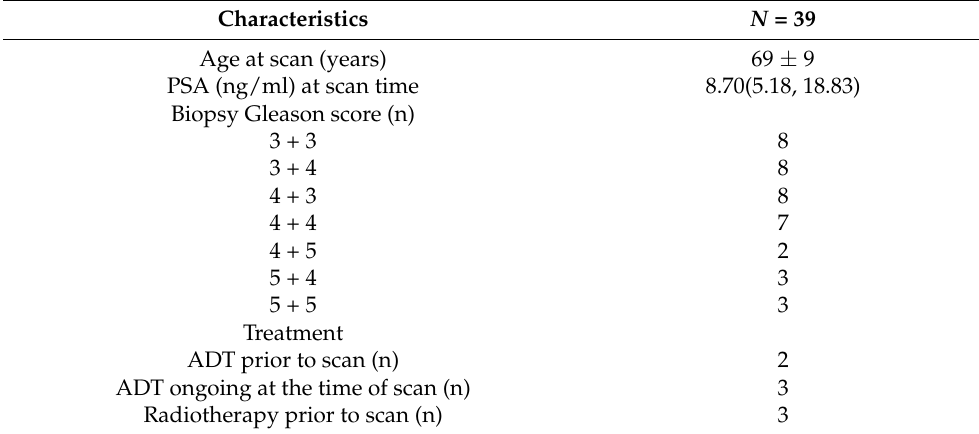
Table 5. Summary of clinical